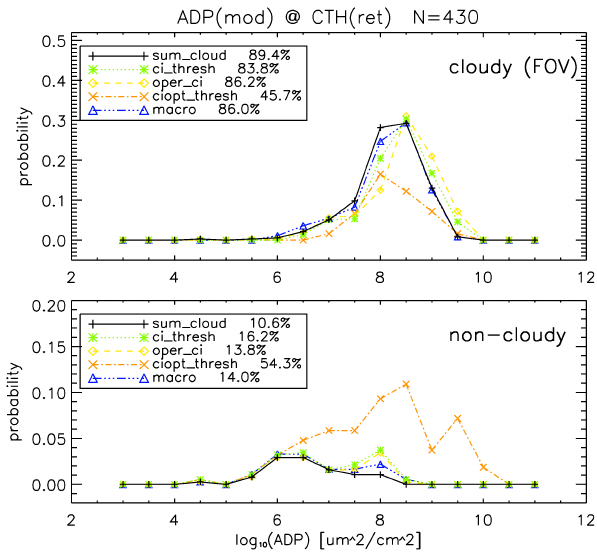
Fig. 10. Same as Fig. 9, but now for the retrievals of the two dif- ferent MIPAS field-of-view convolutions applied to the modelled radiance fields (FOV), see also Sect.